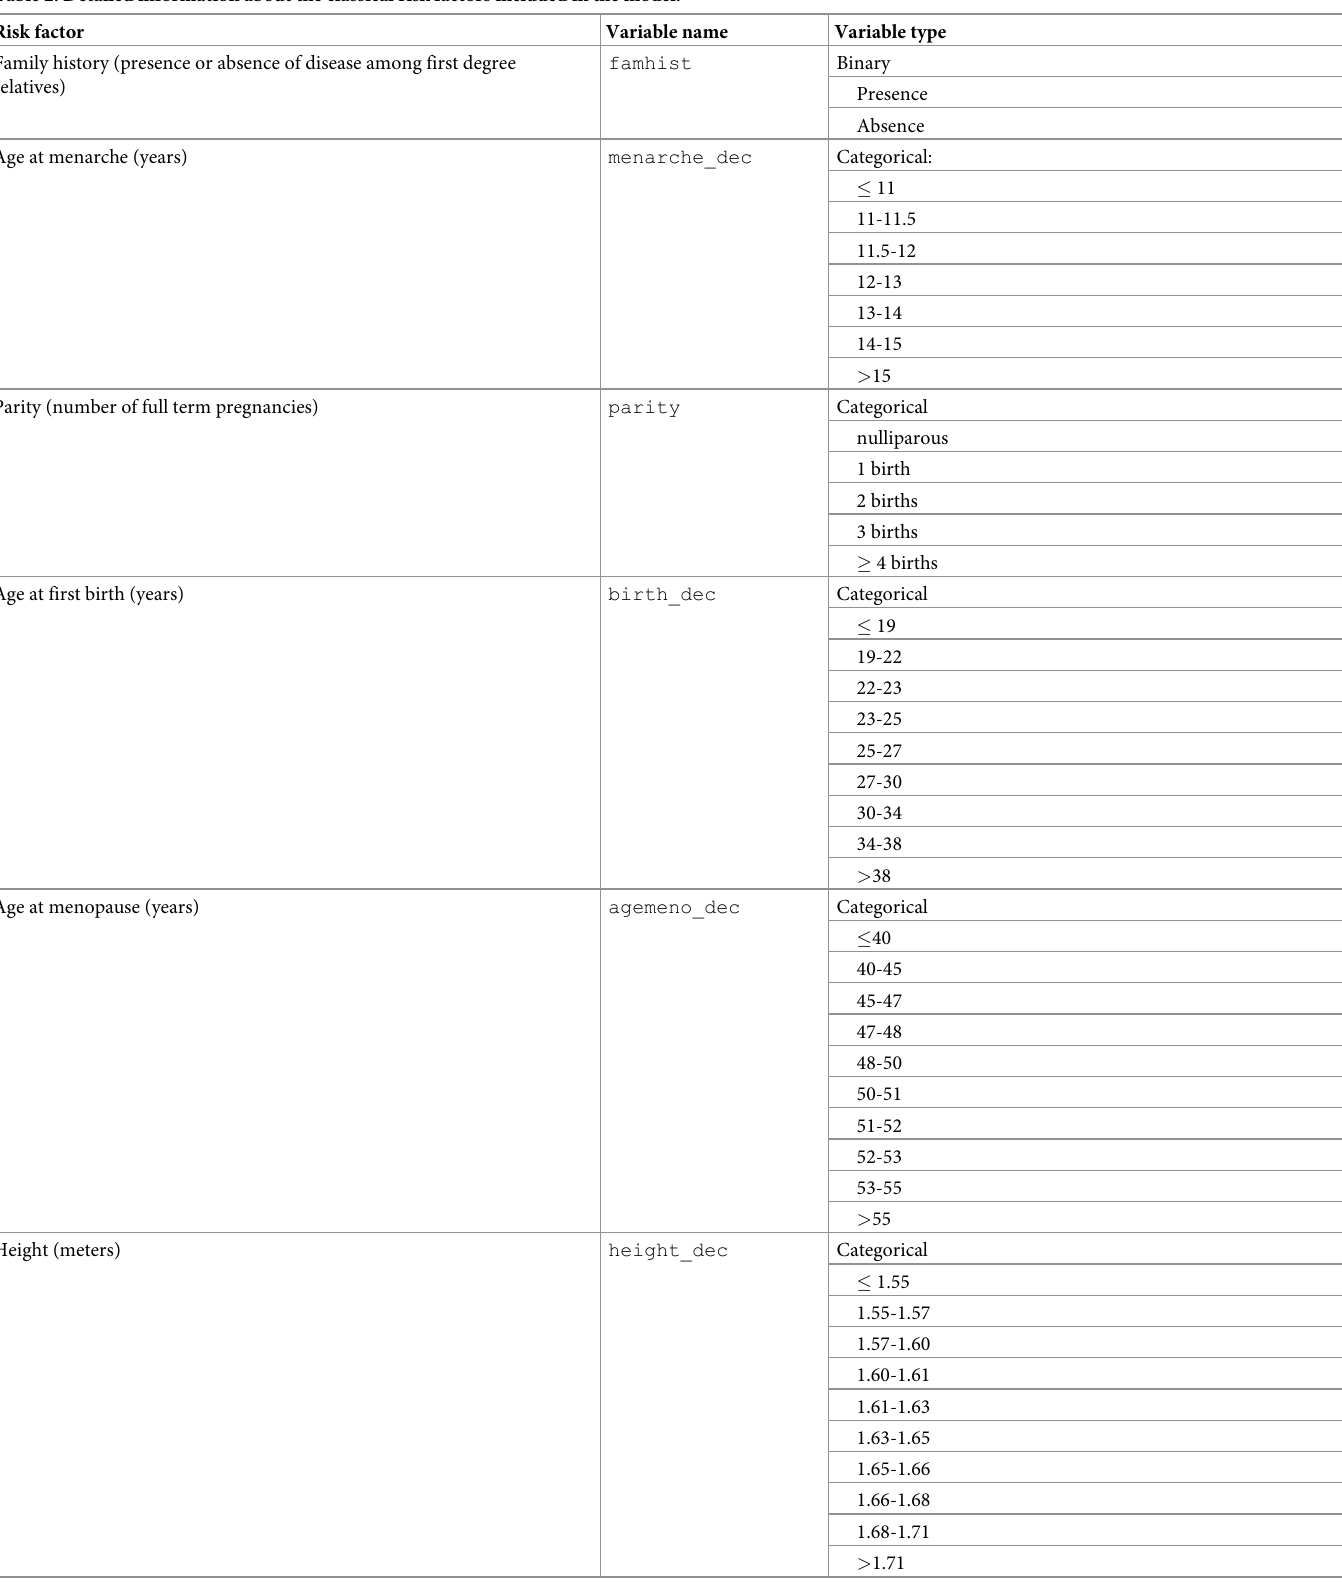
Table 2. Detailed information about the classical risk factors included in the